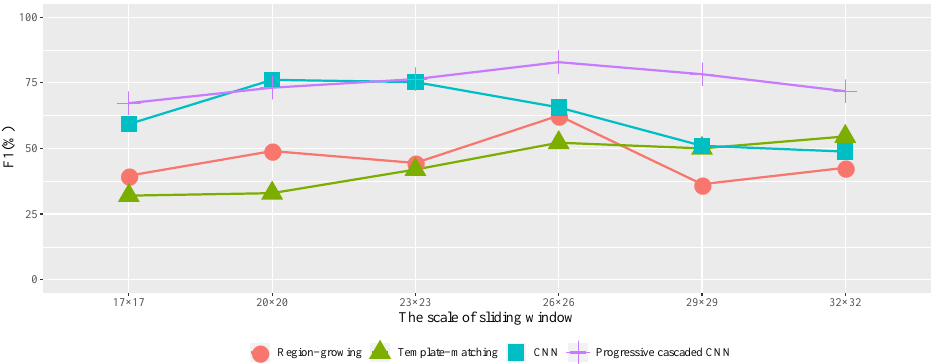
Figure 17. Comparison of detection recall for different methods.